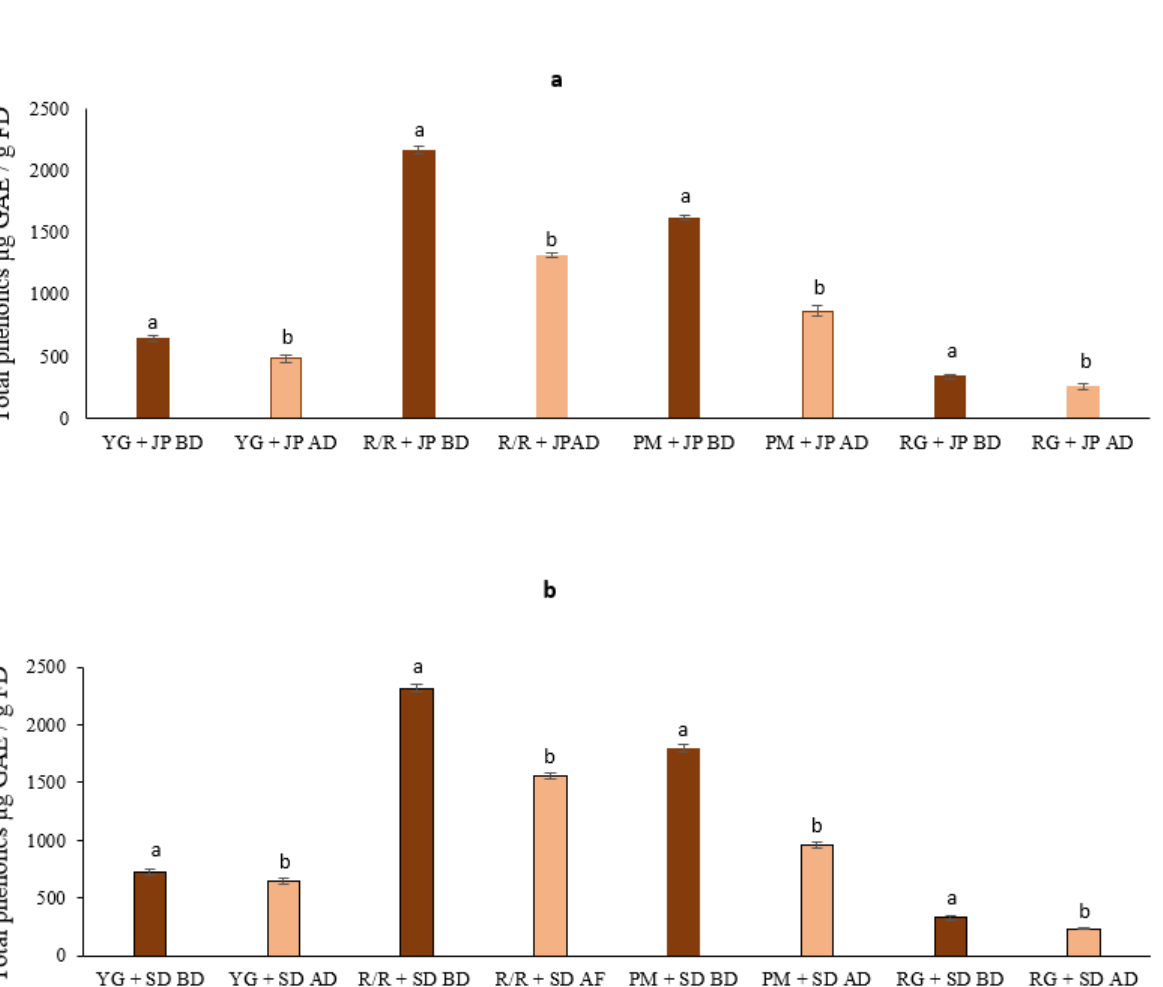
Figure 1. The levels of total phenolics and bioaccessibility of cooked potato varieties mixed with roasted JP ( a ) and with roasted SD ( b ). Data are the mean of three replicates with standard deviation and are expressed as per gram of freeze-dried weight. Significant differences are denoted by different letters, while the same or shared letters indicate that they are not significant to each other. BD and AD: before and after digestion.